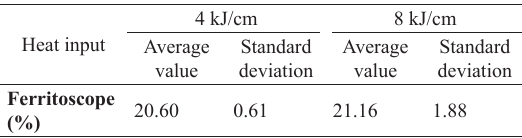
Figure 6. WRC-1992 diagram 28 . Table 3. Quantification of ferrite in the FZ with AWS ER2209 duplex stainless steel filler metal.